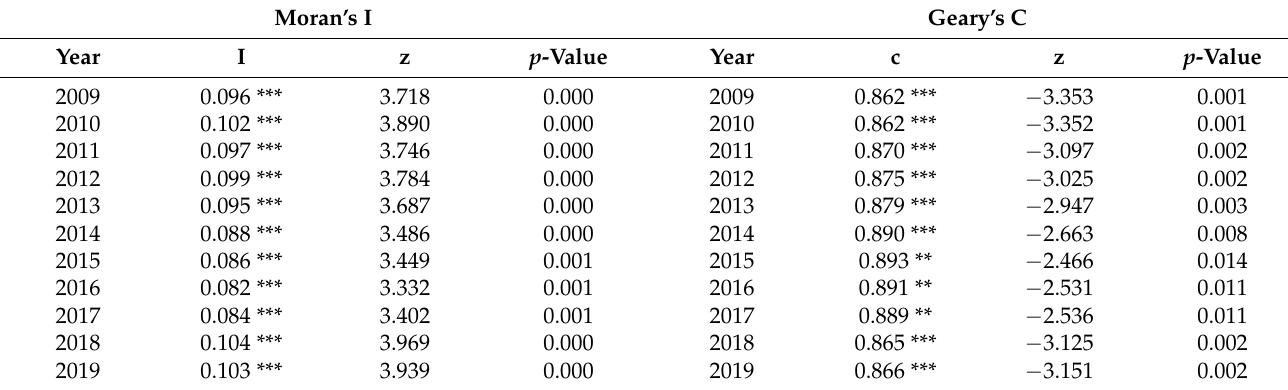
Table 6. Moran’s Index and Grary’s C